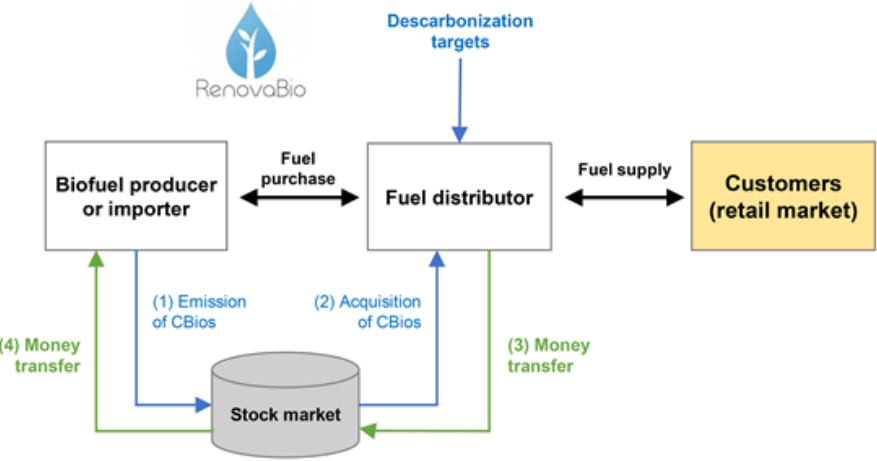
Figure 2. Plan of the emission and trade of decarbonization credits (CBios) created by the RenovaBioProgram, adapted by Klein et al.